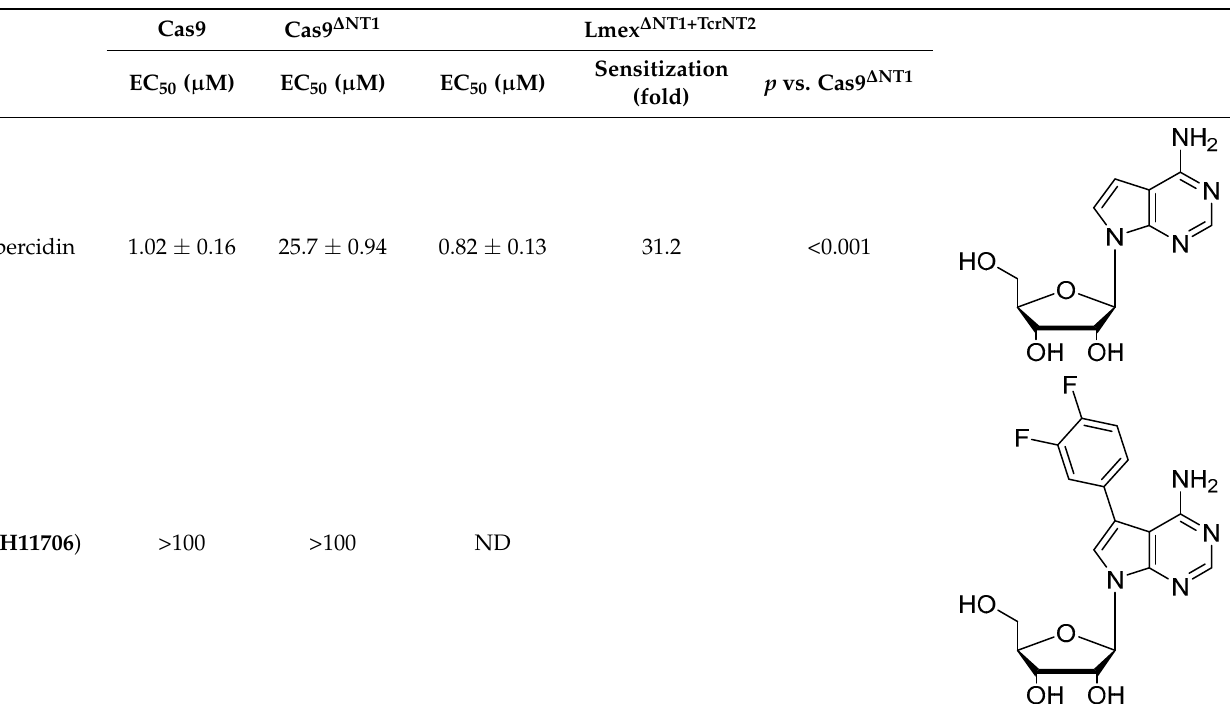
represent averages of triplicate determinations, and error bars indicate ± SEM when not shown error bars fall within the symbol. The graph shown is a single experiment in triplicate, representative of three identical, independent repeats. Table 5. Effects of tubercidin and its analogues on promastigotes of the LmexCas9, Lmex ∆ NT1 and Lmex ∆ NT1+TcrNT2 strains.